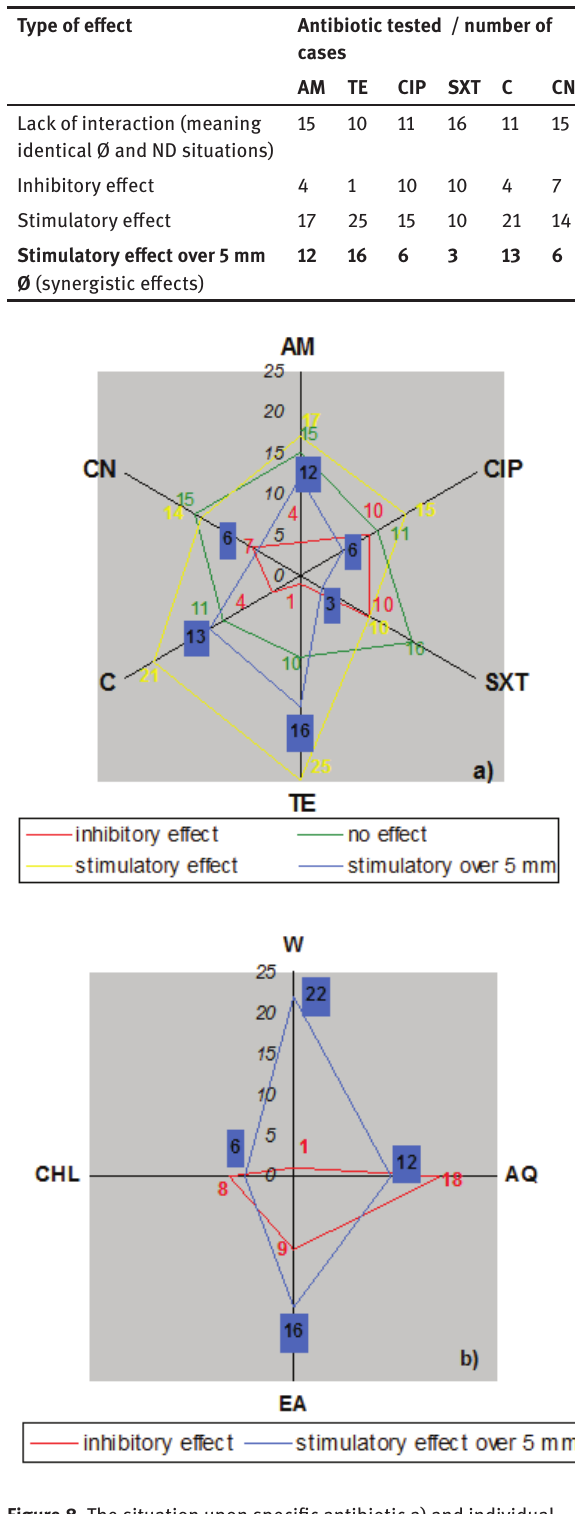
Figure 8. The situation upon specific antibiotic a) and individual extract